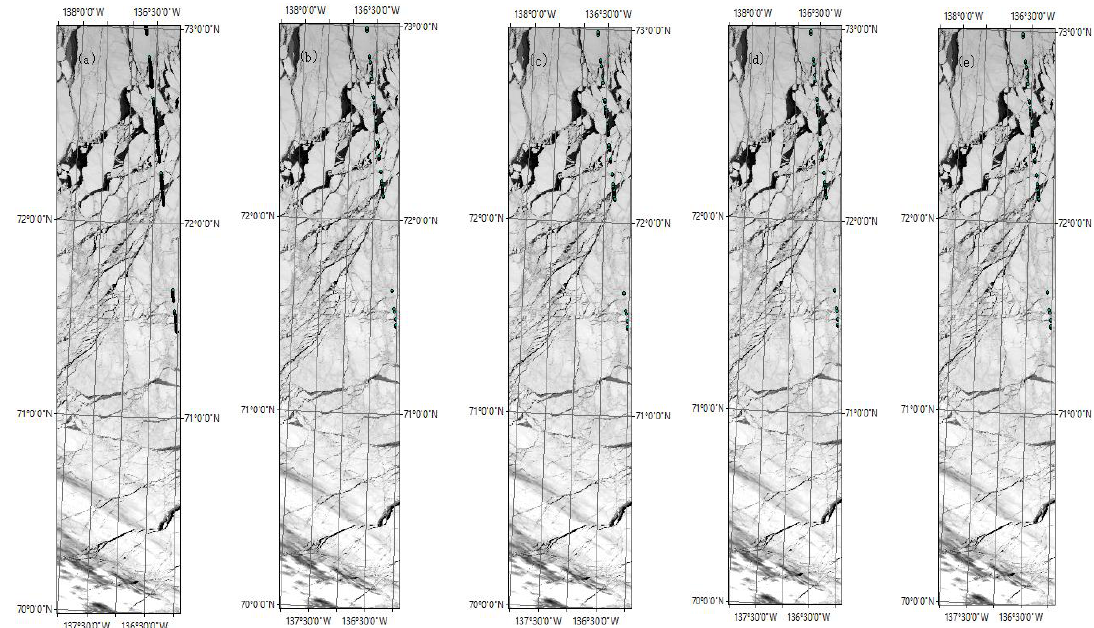
Figure 2. The CryoSat-2 samples have been classified as lead and ice manually by PP (a), PP&SSD (b), PP&SSD&SKU (c) PP&SSD&SSK (d), PP&SSD&SKU&SSK